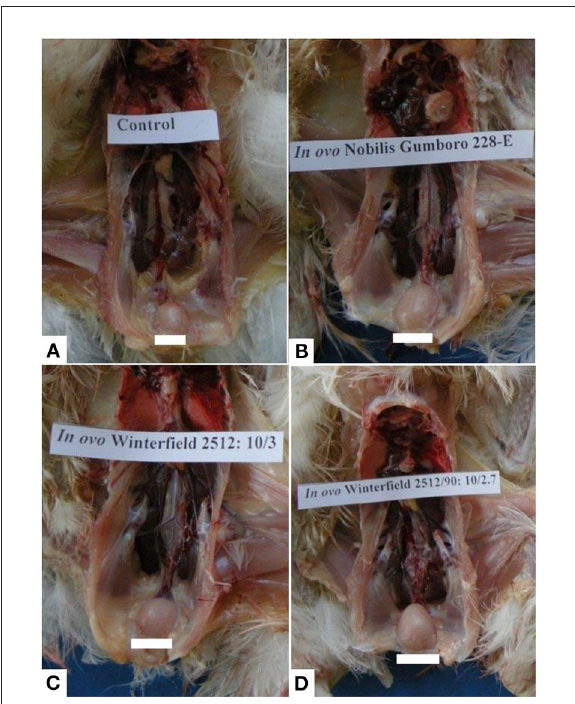
FIGURE1 Bursa of Fabricius of layer chicks at day 28. (A) Control group (normal size of bursa) whereas bursal hypertrophy (B–D) in group A ( in ovo 228 E), group B ( in ovo Winterfield 2512: 10/3) and group C ( in ovo Winter field 2512: 10/2.7) in comparison with control group